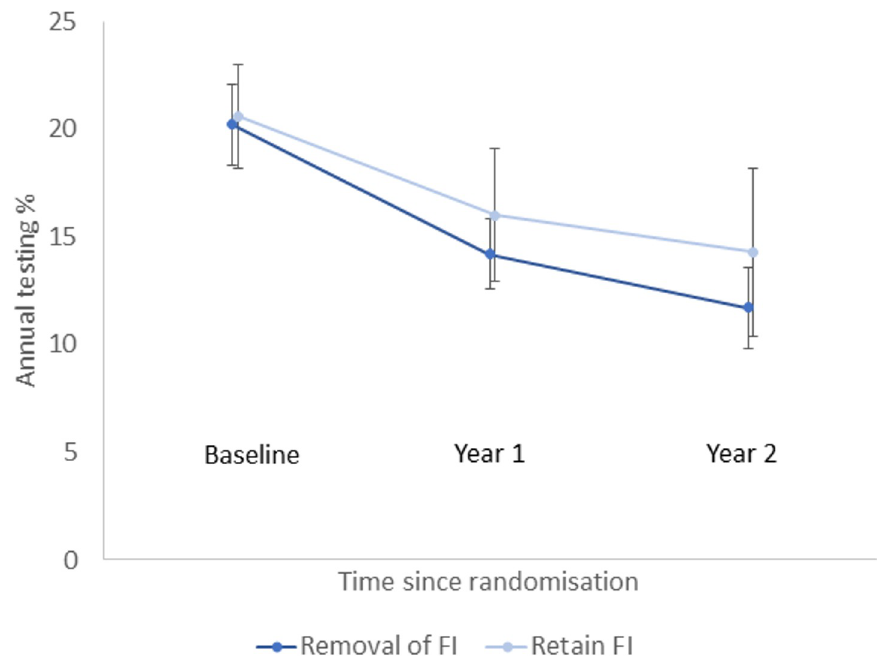
Fig 2. Proportion of patients tested for chlamydia per year by time since randomisation: Factorial analysis— removal of financial incentives versus retention of financial incentives. Error bars correspond to 95% confidence intervals. FI, financial incentives.